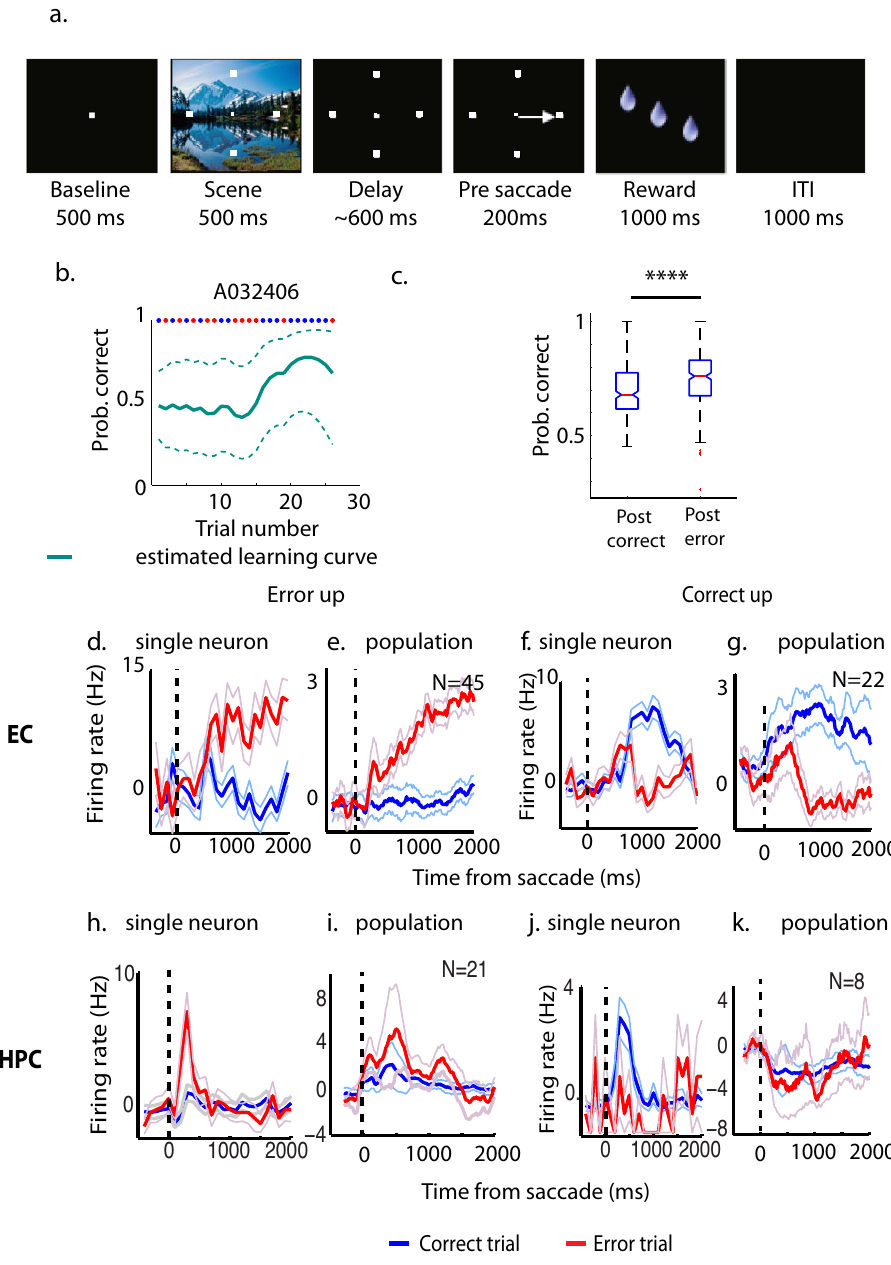
Fig. 1 Location-scene task (LST), performance, and outcome-selective signals. a Schematic illustration of the LST. b Estimated performance of one example LST session. The red dots at the top of the graph indicate error trials and the blue dots indicate correct trials. The teal dashed lines indicated the 95% con fi dence intervals of the estimate. Prob.: probability c Averaged performance immediately after error trials is signi fi cantly better than after correct trials during LST (averaging across 282 sessions, 5 monkeys. Central red marks indicate the median, and the bottom and top edges of the boxes indicate the 25th and 75th percentiles, respectively. The whiskers extend to the most extreme data points not considered outliers, and the outliers are plotted individually using the “ + ” symbol. Notches of the boxes indicate the 95% con fi dence intervals of the estimated median. Individual data points are shown in Supplementary Fig. 7a and data points are listed in Supplementary Data 1). d Time courses of one representative error-up cell in EC. The time courses are averaged across either error trials (red) or correct trials (blue). e Averaged and normalized time courses of population EC error-up cells. f Time courses of one representative correct-up cell in EC. g Averaged and normalized time courses of population EC correct-up cells. h Time courses of one representative error-up cell in HPC. i Averaged and normalized time courses of population HPC error-up cells. j Time courses of one representative correct-up cell in HPC. k Averaged and normalized time courses of population HPC correct-up cells. **** p <0.0001. The light-blue and light-red lines indicate the SD of averaged time